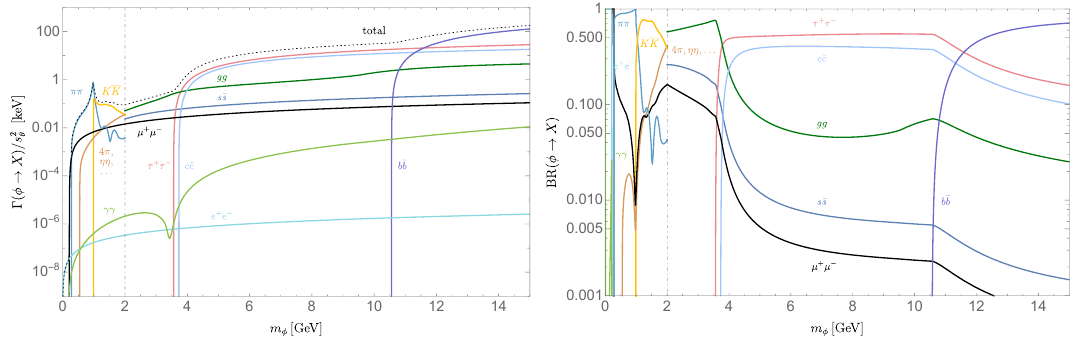
Figure 2 . Decay widths (left) and branching ratios (right) of a light CP -even scalar coupled to the SM via Higgs mixing. The dot-dashed line at m = 2 GeV indicates the point where the description φ of hadronic decays transitions from dispersive methods to a perturbative spectator model, following ref.